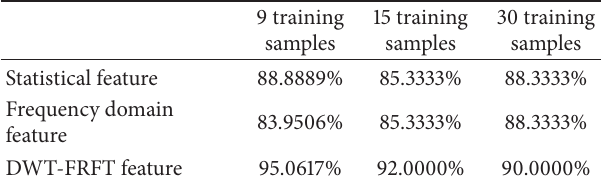
Table 3: Results of